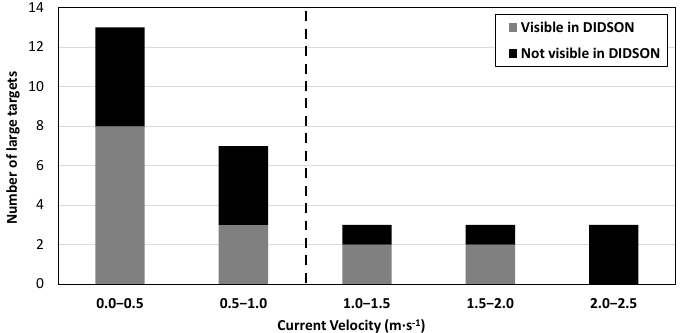
Commented [M1]: Same question with Figure 7. Please confirm whether figure 7(B) should be added or the explanations should be revised. Commented [GS2R1]: Fixed.